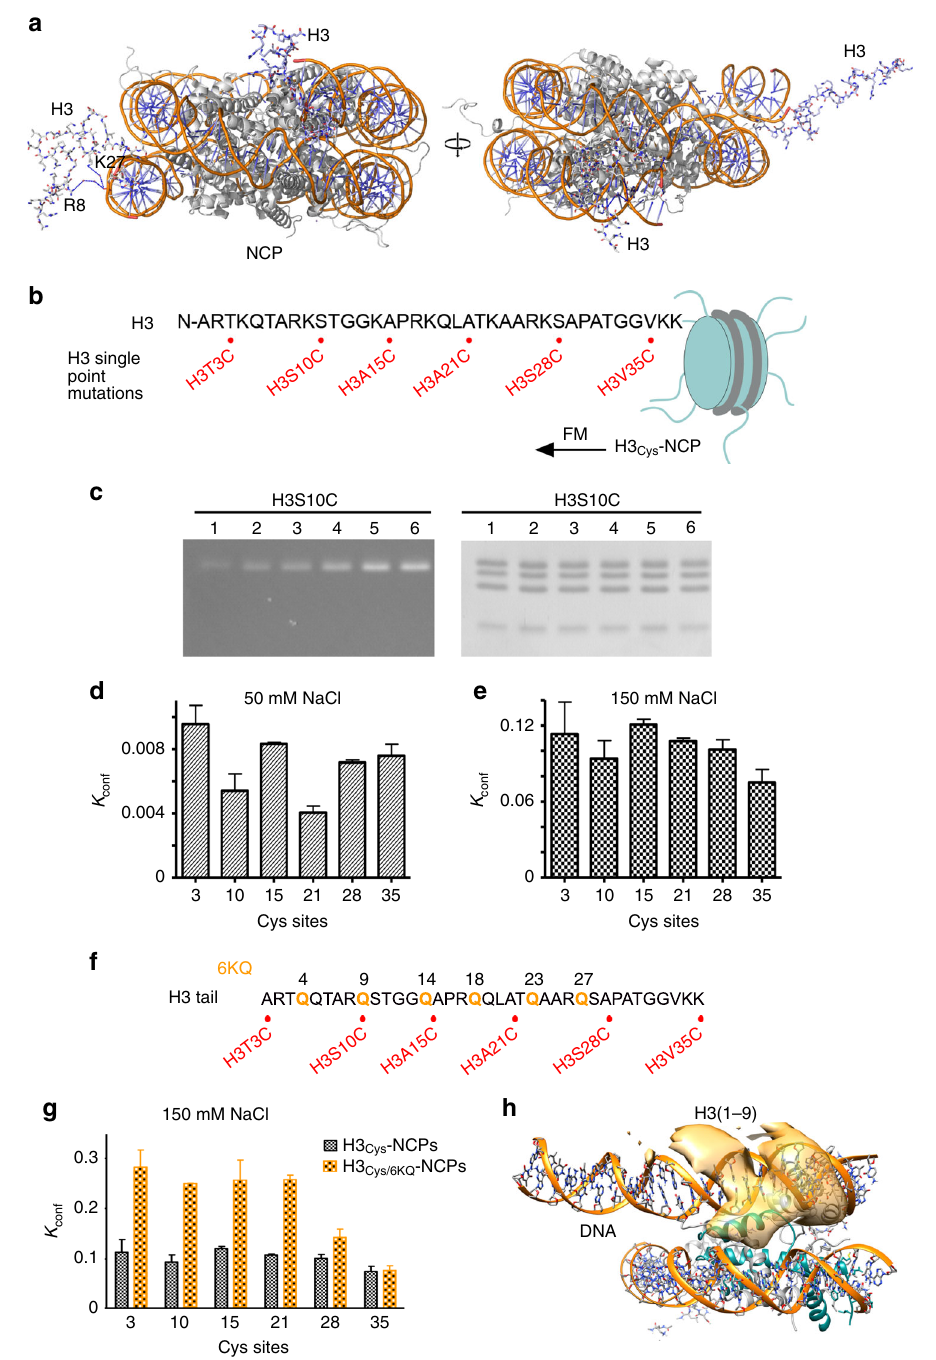
Fig. 2 H3 tails in the nucleosome are less accessible to readers. a Ribbon diagram of the crystal structure of NCP (PDB ID 1KX5). Histone H3 tails are shown in a stick model with residues in close proximity to DNA labeled. b Schematic showing H3 tail sequence and location of cysteine substitutions. c Example of time course for nucleosomes containing H3S10C reacted with FM at 150 mM NaCl for 10, 20, 30, 60, 120, and 300 s shown in lanes 1 – 6, respectively. The gel was directly imaged by fl uorography (left) then stained to reveal the histone proteins (right). d , e K eq values determined at indicated cysteine substitutions within H3 tail in buffer containing 50 mM ( d ) and 150 mM ( e ) NaCl. The error bars represent SD based on three or more experiments. f Schematic showing H3 tail sequence and location of six lysine to glutamine mutations (K4Q, K9Q, K14Q, K18Q, K23Q, and K27Q) and six cysteine substitutions (T3C, S10C, A15C, A21C, S28C, and V35C) in H3 tail. g K eq values determined at indicated cysteine substitutions within H3 tail. The error bars represent SD based on three or more experiments. h The spatial distribution of the N-terminal region (residues 1 – 9) of H3. The area where 30% of the tails in the ensemble are positioned is colored